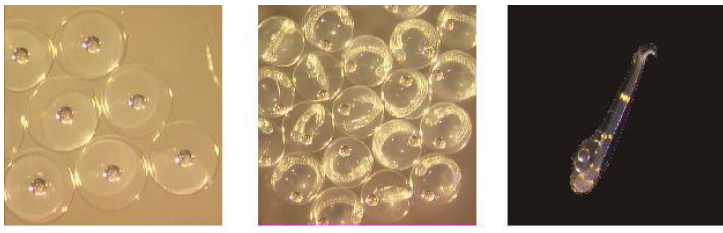
FIGURE 4. Control eggs before (a) and after (b) gastrulation, as well as control larva (c) of the seabream, Sparus aurata .